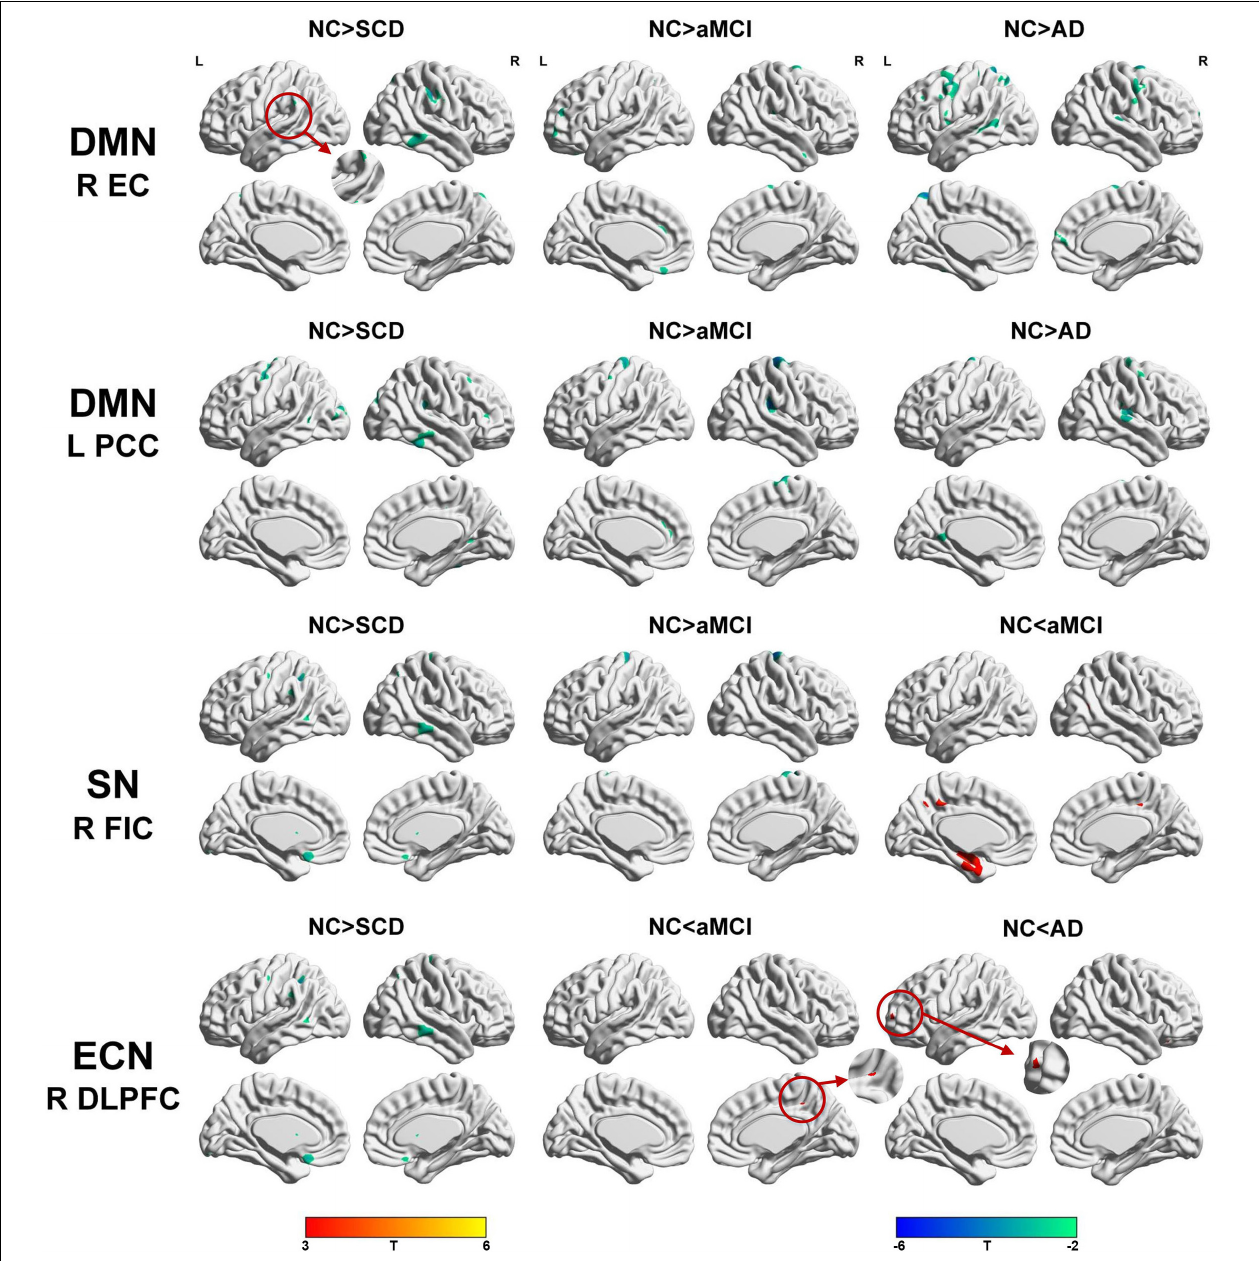
FIGURE 4 | Between-group (NC-SCD; NC-aMCI; and NC-AD) differences in structural covariance networks seeding from the default mode network, salience network, and executive control network. T-statistic maps, p < 0.01 at the voxel level and p < 0.05 at the cluster level, two-tailed Gaussian random field (GRF) correction with cluster size larger than 100 voxels. The small clusters are circled by the red circles, and they are enlarged. L, left; R, right; EC, entorhinal cortex; PCC, posterior cingulate cortex; DLPFC, dorsolateral prefrontal cortex; FIC, frontoinsular cortex; AD, Alzheimer’s disease; NC, normal control; aMCI, amnestic mild cognitive impairment; SCD, subjective cognitive